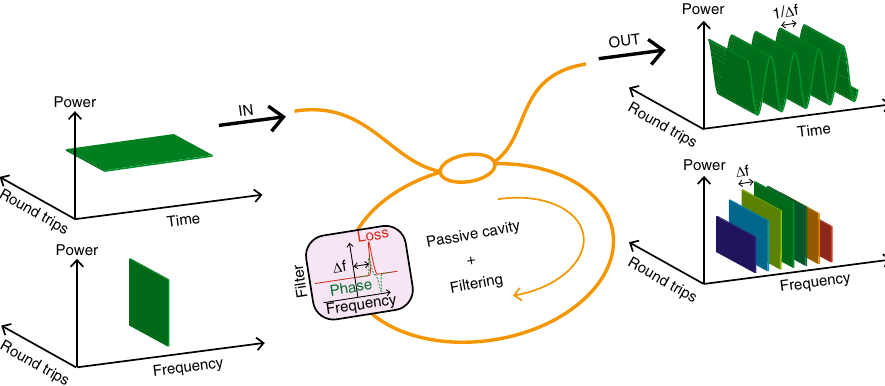
Fig. 1 Concept of GTF comb in a passive resonator. A fi bre ring resonator, including an asymmetric loss element ( fi lter) is pumped by a CW laser. At the output, an OFC is generated with a teeth spacing imposed by the frequency shift Δ f between the pump and the fi